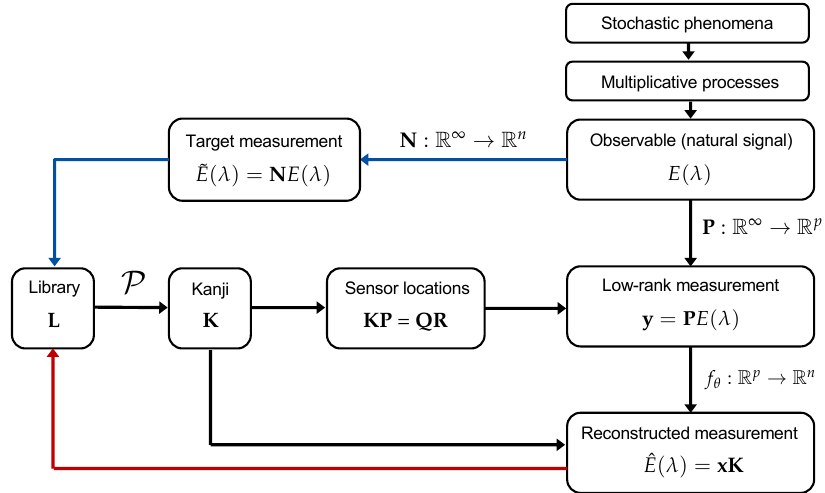
Figure 3. An integrated framework for synthesizing new information into a tractable dictionary K Figure 6.18: Neural network architectures commonly considered in the litera- Figure 6.18: Neural network architectures commonly considered in the litera- Figure 6.18: Neural network architectures commonly considered in the litera- and optimal encoder structure P . As data are collected, they are fed back into the overcomplete library. ture. The NNs are comprised of input nodes, output nodes, and hidden nodes. ture. The NNs are comprised of input nodes, output nodes, and hidden nodes. ture. The NNs are comprised of input nodes, output nodes, and hidden nodes. Process is expanded in Figure Additionally, the nodes can have memory, perform convolution and/or pool- Additionally, the nodes can have memory, perform convolution and/or pool- Additionally, the nodes can have memory, perform convolution and/or pool- P ing, and perform a kernel transformation. Each network, and their acronym is ing, and perform a kernel transformation. Each network, and their acronym is ing, and perform a kernel transformation. Each network, and their acronym is explained in the text. explained in the text. explained in the text.